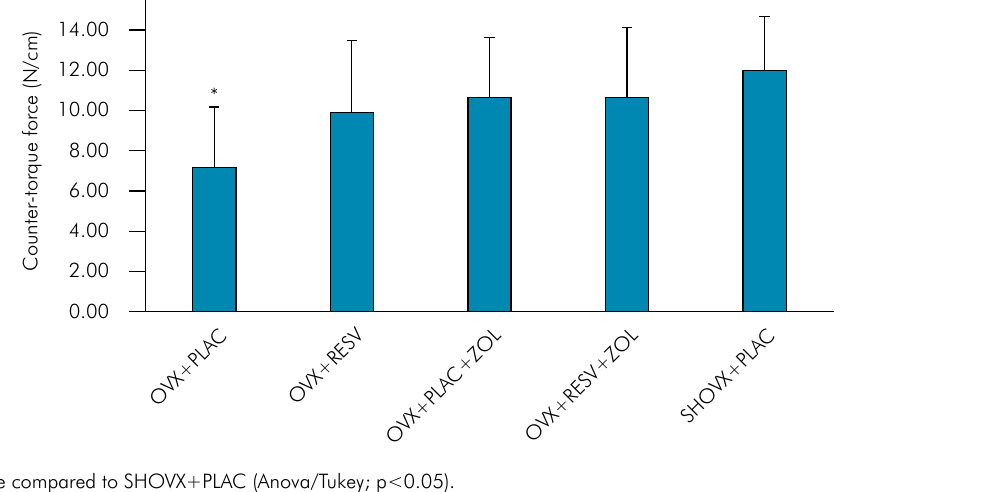
Figure 2. Means and standard deviations of counter-torque values in all experimental